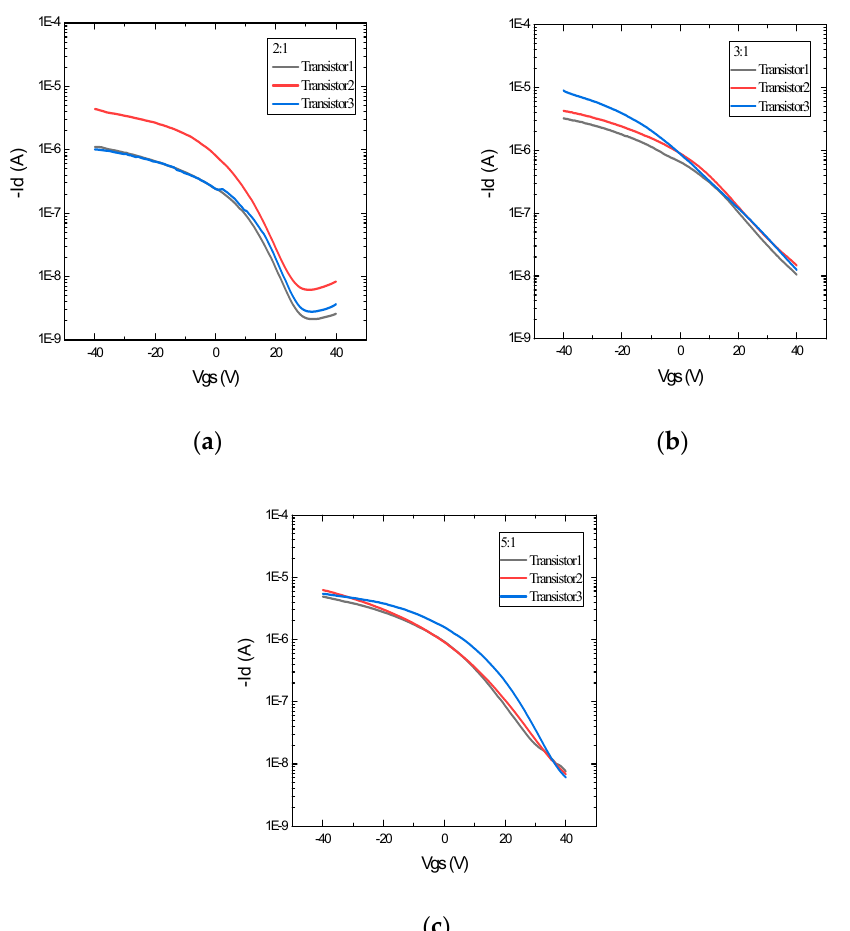
Figure 7 . Transfer characteristics of printed devices with PVP-PMF dielectrics at various weight ratios: ( a ) 2:1, ( b ) 3:1, and ( c ) 5:1 . ratios: ( a ) 2:1, ( b ) 3:1, and ( c )